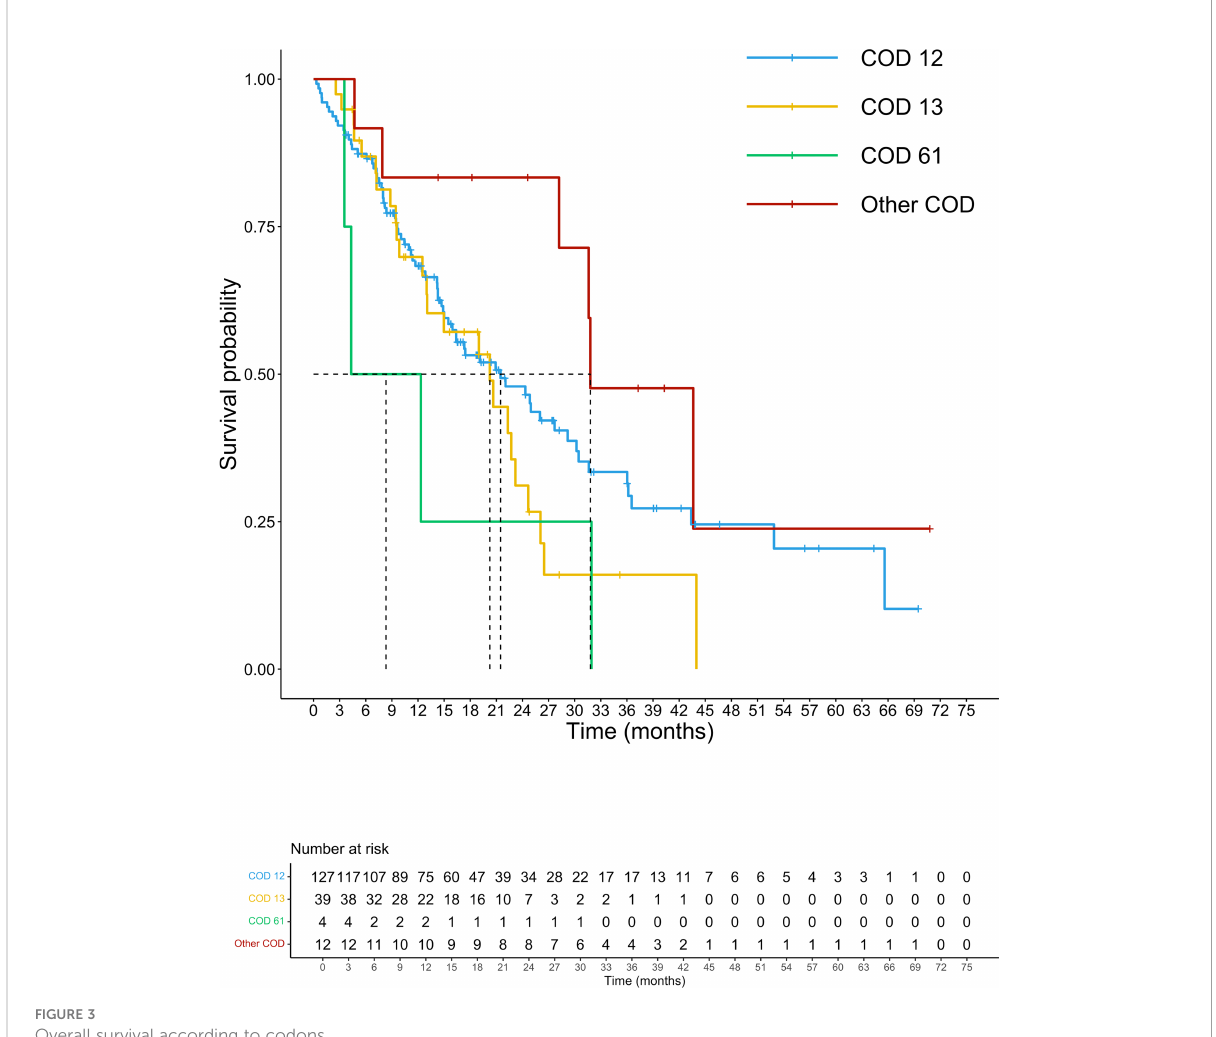
FIGURE 3 Overall survival according to